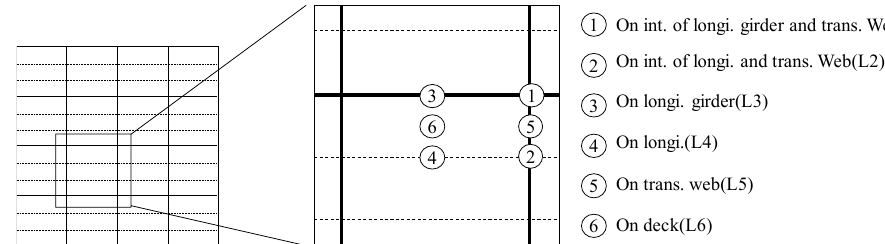
Figure 8. FE model of the deck structure of Shinan Ferry No. 5. ( a ) Isometric view—Top surface; ( b ) Isometric view—Bottom surface.